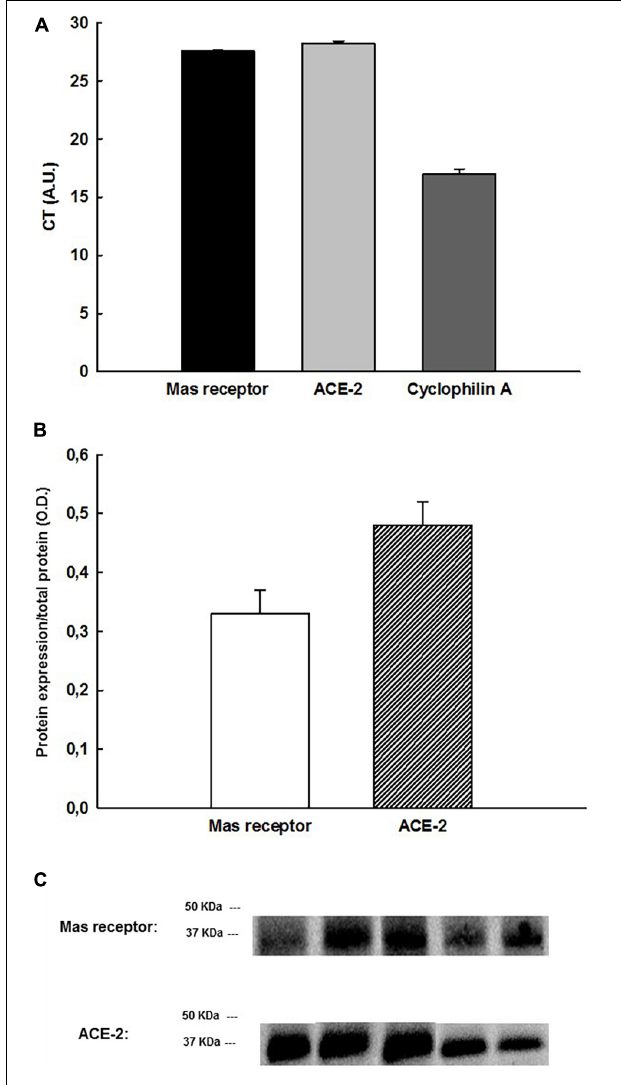
FIGURE 7 | (A) CT values obtained by qPCR, showing the gene expression of Mas receptors, ACE-2 and cyclophilin A (housekeeping gene) in the LPA neurons ( n = 6), (B) protein expression of Mas receptors and ACE-2 normalized by total protein in the LPA neurons by Western blotting ( n = 6), (C) blots labeled for Mas receptors and ACE-2 in LPA samples by Western